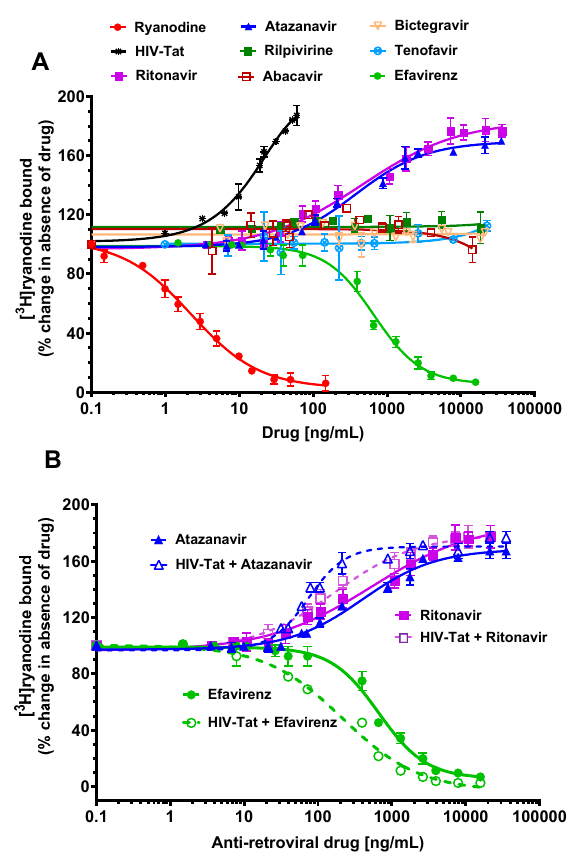
Figure 1. ( A ) : Effects of Tat (HIV-Tat), abacavir (ABC) , atazanavir (ATV), bictegravir (BIC), efavirenz (EFV), tenofovir disoproxil fumarate (TDF), Rilpivirine (RPV), ritonavir (RTV), and the prototype ligand ryanodine on equilibrium [ 3 H]ryanodine binding to RyR2. For these experiments, sarcoplas- mic reticulum membrane vesicles isolated from bovine hearts were incubated in a buffer containing 500 mM KCl 20 mM Tris·HCl, 0.03 mM Ca 2+ , and 6.7 nM [ 3 H]ryanodine, with a pH of 7.4 and with varying concentrations of HIV-Tat, ABC, ATV, BIC, EFV, TDF, RPV, RTV, and the prototype ligand ryanodine for 2 h at 37 °C. After this, the samples were filtered, and the [ 3 H]ryanodine bound to